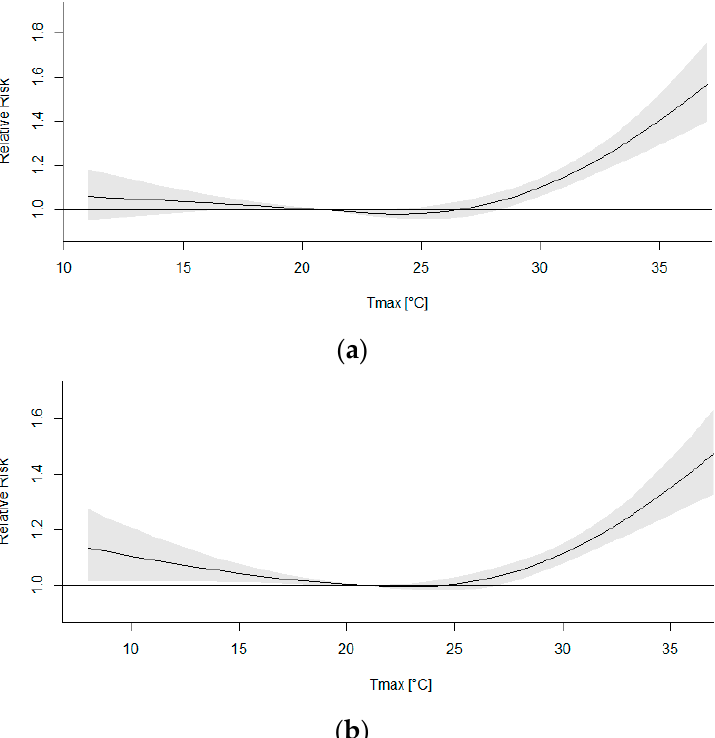
Figure 4. Relation between daily maximum temperature and relative mortality risk (all non-accidental causes) in warm months (June–September) during 2001–2016 for: ( a ) Pozna ń ; ( b ) Kraków.